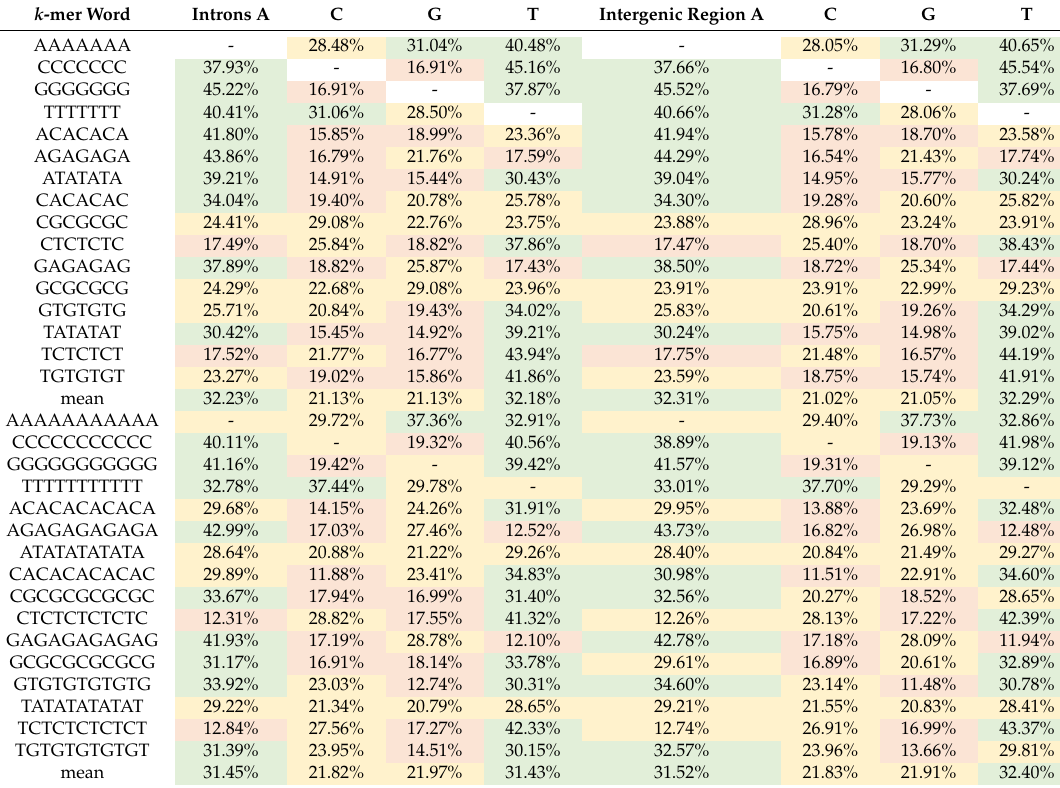
Table 8. Contents of specific nucleotides (A, C, G, T) within mismatches of tandem repeat k -mer words (for k = 7 and k = 11). Contents lower than 20% are marked red, and contents higher than 30% are marked green, remaining contents are marked